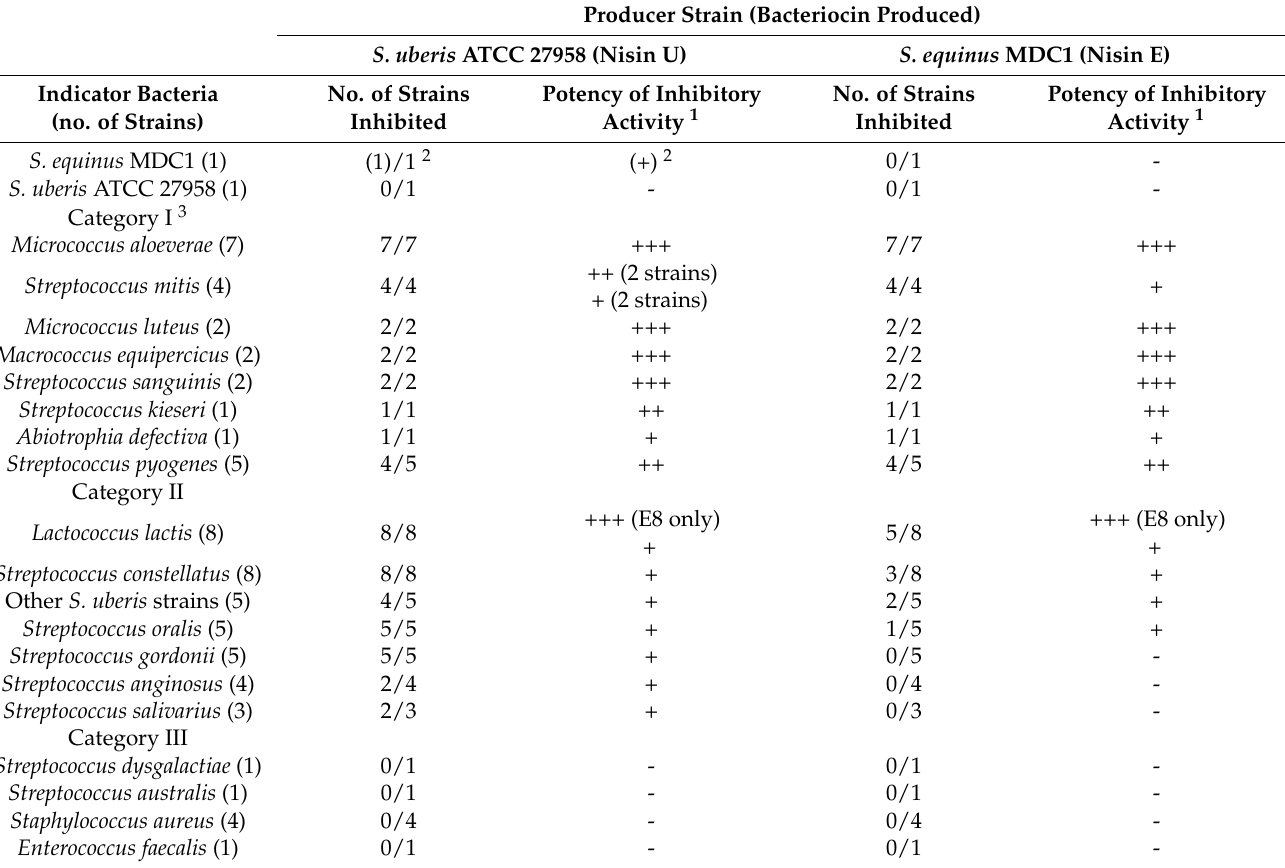
Table 2. Comparison of the bacteriocin activity spectra of nisin U and the MDC1 BLIS (nisin E). Producer Strain (Bacteriocin